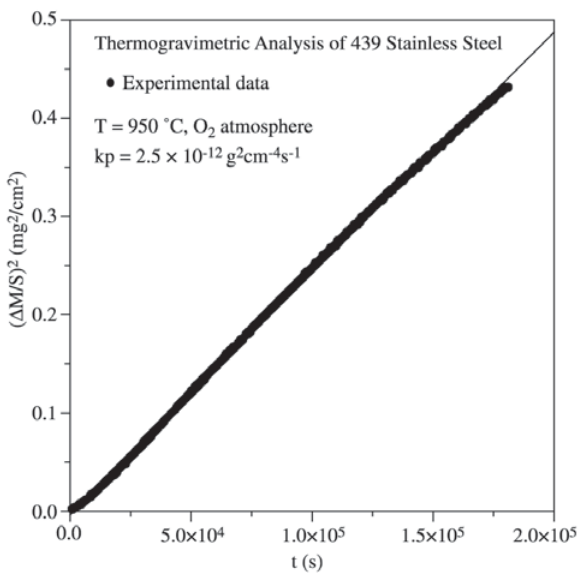
Figure 2. Quadratic plot of Fig. 1 showing that the oxidation ki- netics obeys a parabolic law.